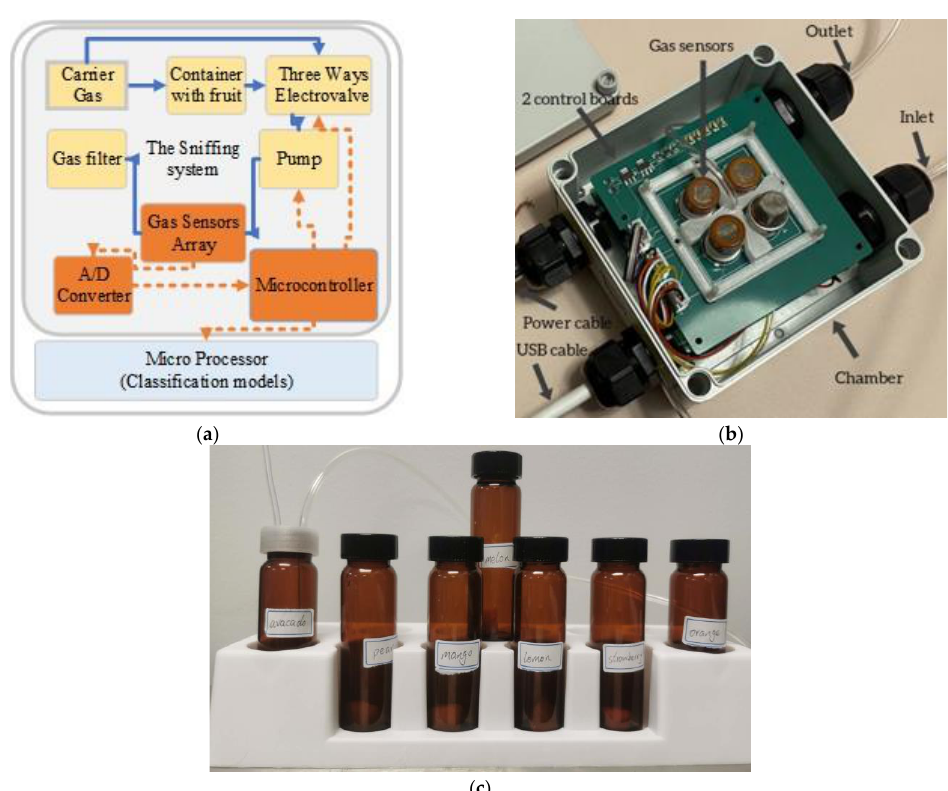
Figure 1. The intelligent gas-sensing system: ( a ) the architecture of the intelligent gas-sensing system is built up with a gas control module (top), signal sampling module (middle), and classification module (bottom); ( b ) the hardware of the sniffing system, a chamber containing an array of gas sensors, A/D converter, micro control unit, gas inlet, and outlet on its edge; ( c ) 7 types of peeled fruits were placed in containers separately.